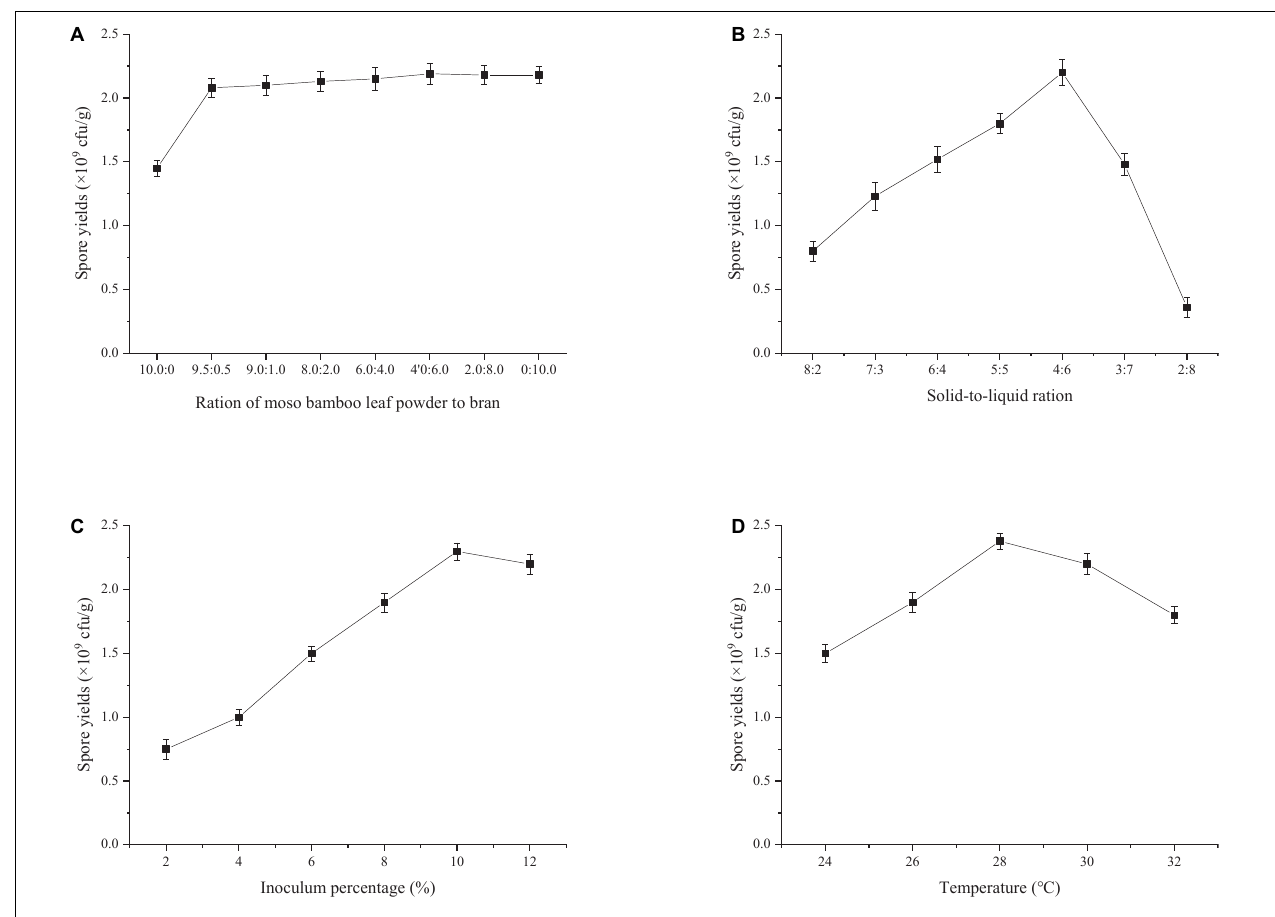
FIGURE 4 | Effects of fermentation conditions on spore production. After each factor was optimized, the optimal condition was substituted into the optimization experiment of the next factor. The experiments were repeated three times. (A) Effect of the ratio of moso bamboo leaf to bran on sporulation (10:0, 9.5:0.5, 9.0:1.0, 8.0:2.0, 6.0:4.0, 20:8.0, and 0:10.0). Solid-to-liquid ratio (5:5), inoculum percentage (8%), fermentation temperature (28 ◦ C). (B) Effect of solid-to-liquid ratio on sporulation (8:2, 7:3, 6:4, 5:5, 4:6, 3:7, 2:8). The ratio of moso bamboo leaf to bran (9.5:0.5), inoculum percentage (8%), fermentation temperature (28 ◦ C). (C) Effect of inoculum percentage on sporulation (2, 4, 6, 8, 10, and 12%). The ratio of moso bamboo leaf to bran (9.5:0.5), solid-to-liquid ratio (4:6), fermentation temperature (28 ◦ C). (D) Effect on fermentation temperature on spore production (24, 26, 28, 30, and 32 ◦ C). The ratio of moso bamboo leaf to bran (9.5:0.5), solid-to-liquid ratio (4:6), inoculum percentage